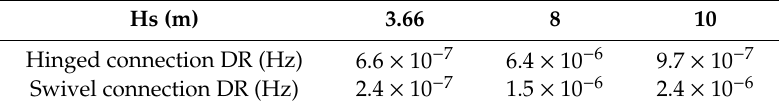
Figure 18. Fatigue damage rate (Hz) for different cases. Table 13. Sensitivity of tower fatigue damage rater to significant wave height ( H s ).